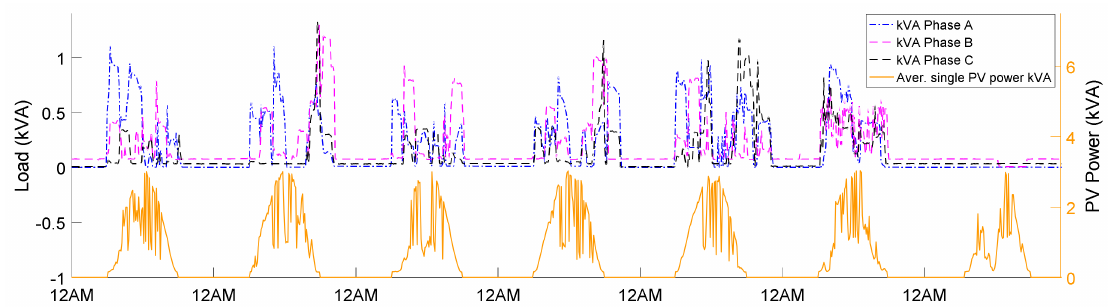
Figure 8. Vrms at point of common coupling (PCC) during one week with PV injection.